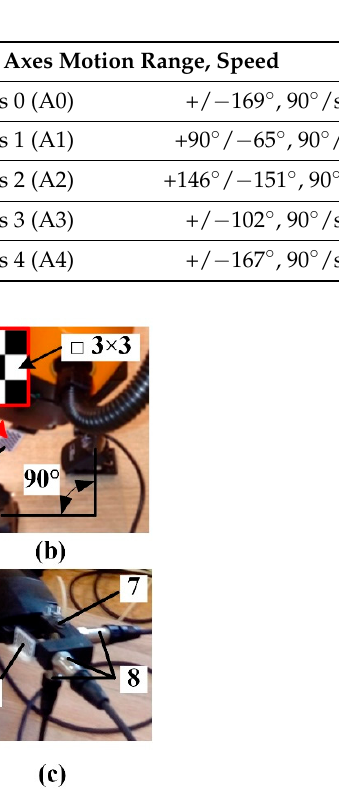
Table 1. Parameters of the implemented algorithm.